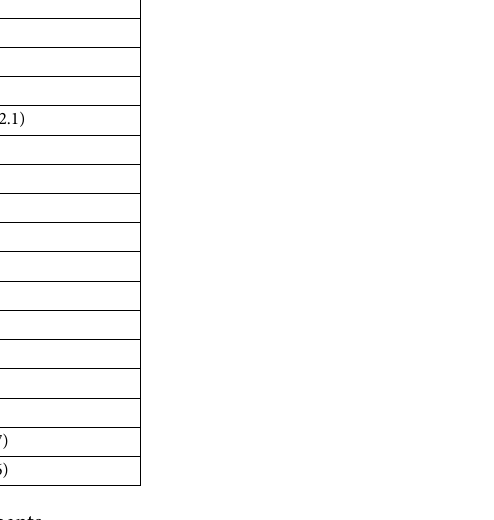
Table 1. Characteristics of study group